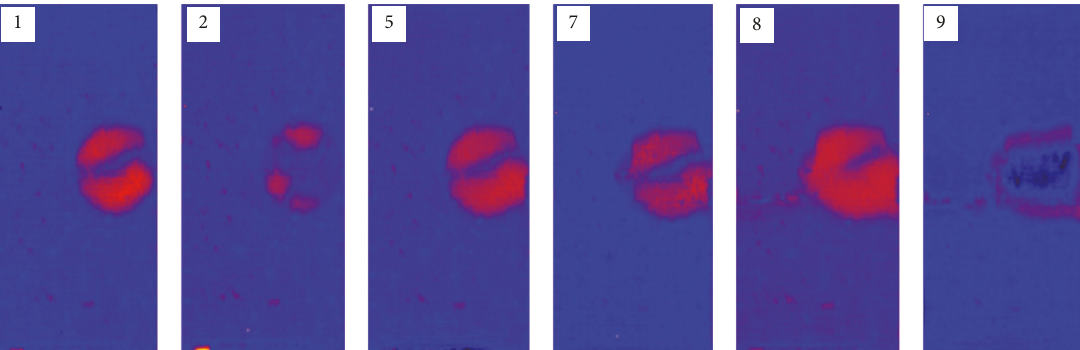
Figure 21: Delamination development-principal step-side delamination specimen.